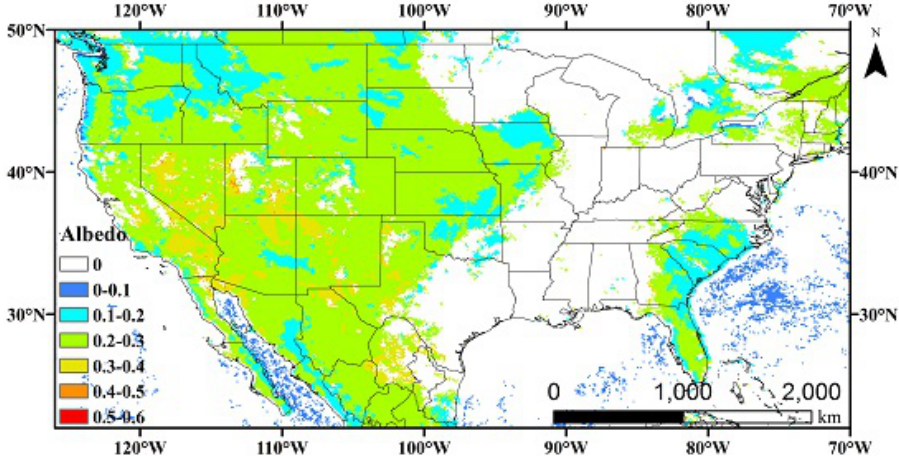
Figure 3. Daily averaged shortwave black-sky albedo from EPIC on 4 June, 2016 in the study area. 0 represents the area without value because of inversion failure caused by clouds,